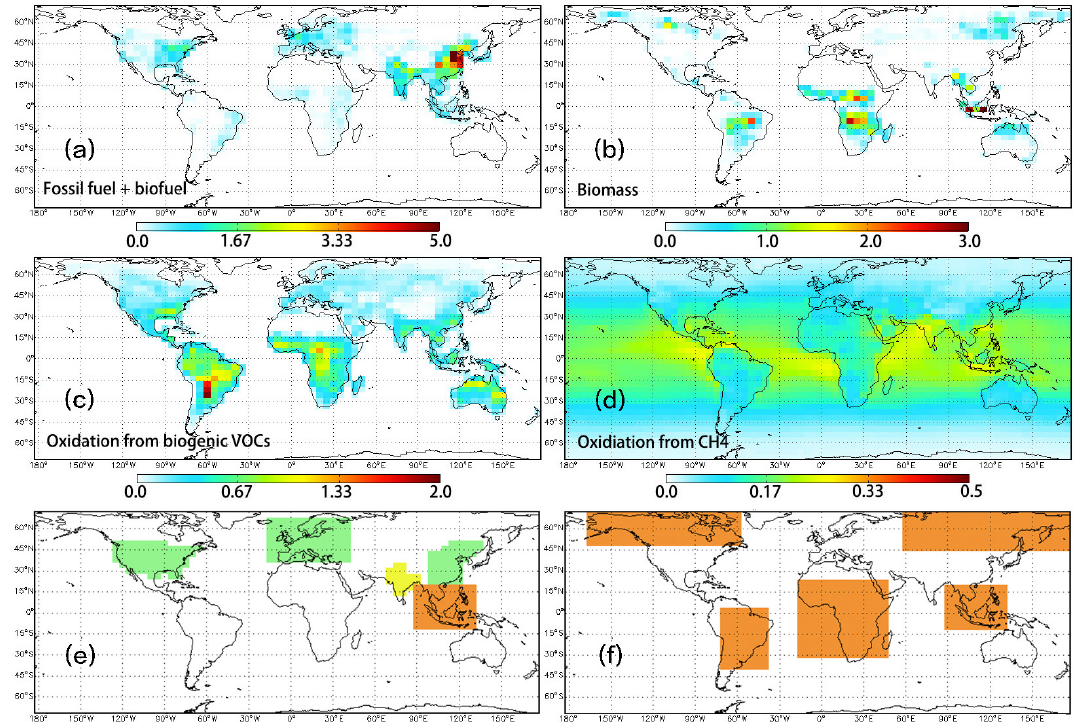
Figure 2. (a–d) Mean a priori CO emissions from combustion sources and the oxidation of biogenic VOCs and CH 4 from 2001 to 2015. The unit is 10 12 moleccm − 2 s − 1 . (e–f) Region definitions for (e) anthropogenic and (f) biomass burning